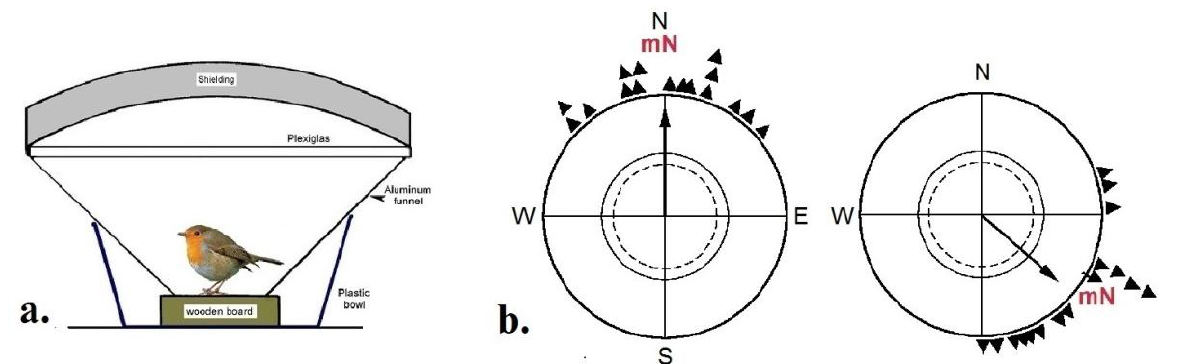
Figure 1. ( a ) Section through a frequently used test cage for recording the activity of a migratory bird [11]. ( b ) Orientation of robins during spring migration ( left ) in the local geomagnetic field and ( right ) with magnetic North turned by 120° to ESE (data from [13]). The triangles at the periphery of the circle mark the mean headings of individual birds, the arrow represents the grand mean vector based on these headings drawn proportional to the radius of the circle. The two inner circles indicate the 5% (dotted) and the 1% significance border of the Rayleigh test